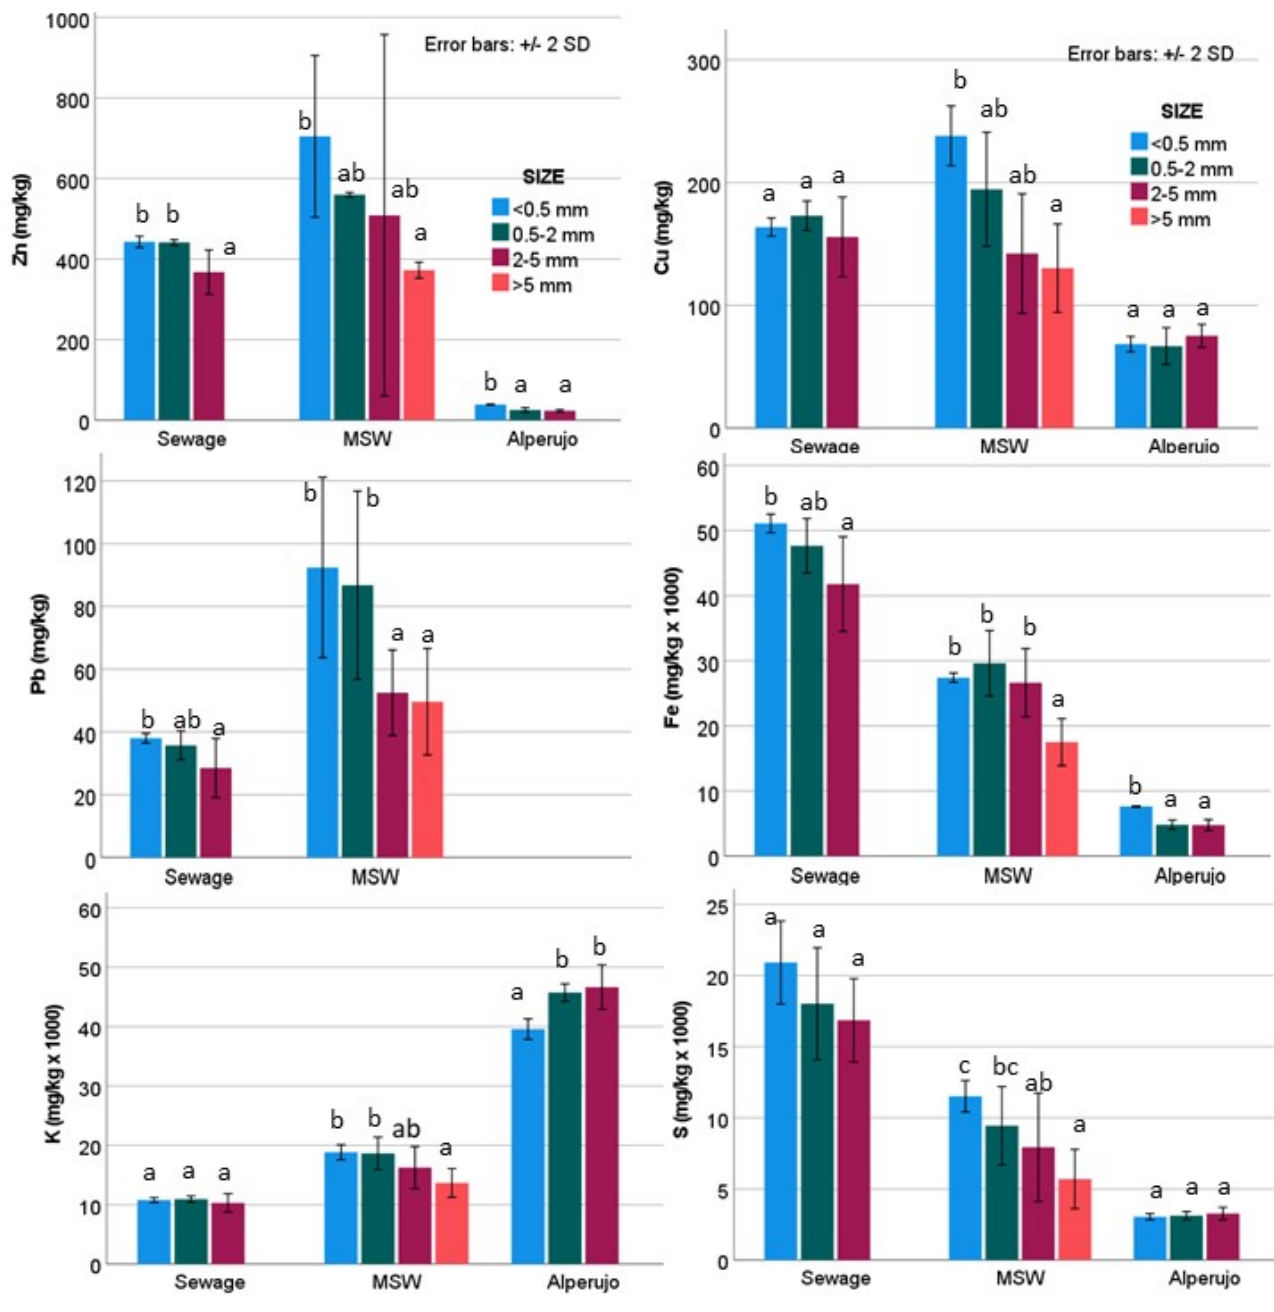
Figure 1. Concentrations of various elements in the ground granulometric fractions of the sludge compost, MSW compost, and alperujo compost. Bars with the same lower letter do not differ statistically according to Tukey’s test ( p < 0.05).